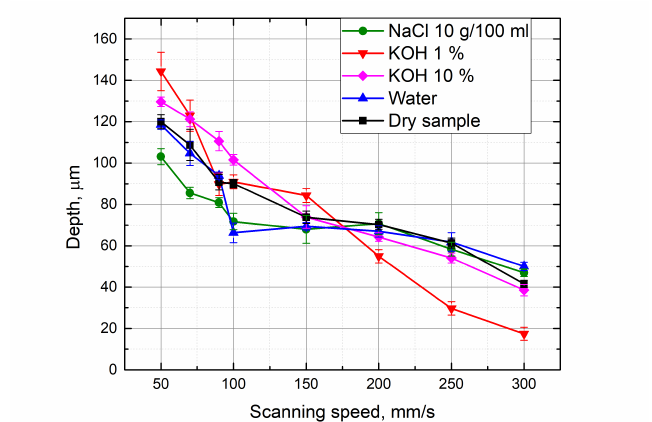
Figure 7. Depth of the grooves formed in the glass sample in dependence on the scanning speed. Grooves were formed while the glass sample surface was dry and immersed in different concentrations (1%, 10% KOH, 10 g/100 mL NaCl) aqueous solutions, water. Number of scans—15, average power—5 W, pulse repetition rate—60 kHz.